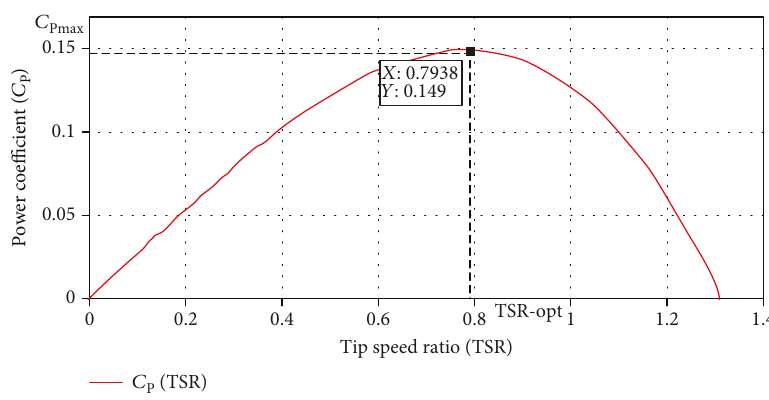
Figure 5: Curve characteristic of TSR-based power coe ffi